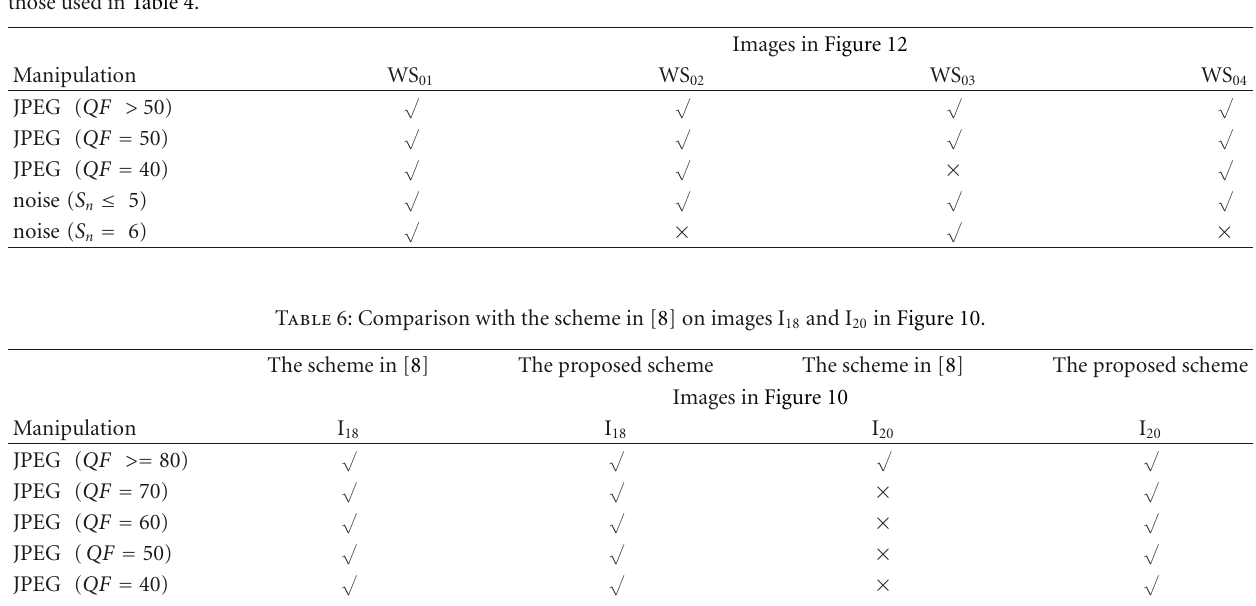
√ and × have the same meanings as